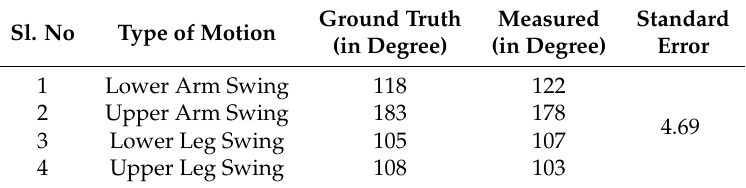
Figure 12. Swing angle measurement between the target bone segment and its parent bone segment for the ground truth. Table 1. Swing visualization accuracy of Motion-sphere against the ground truth: the measured swing is with respect to the parent joint segment.